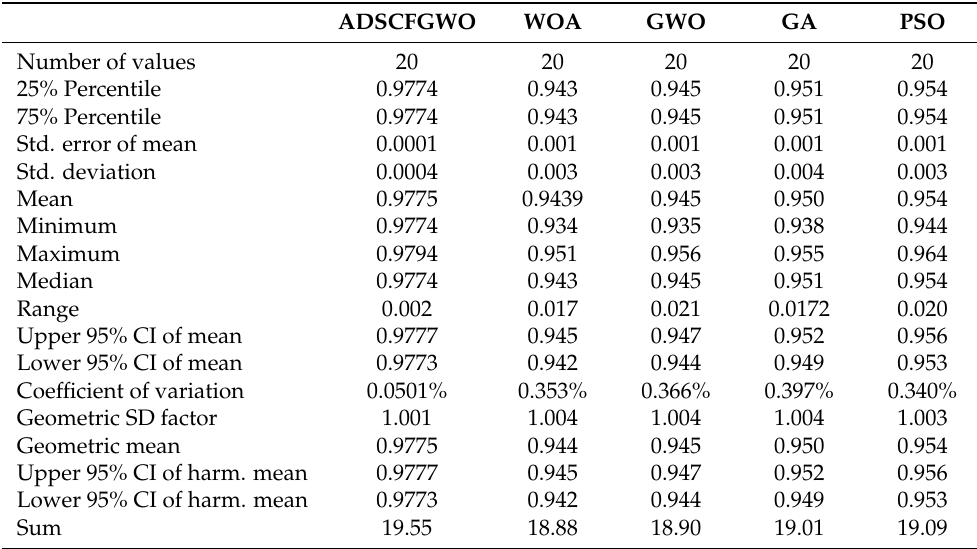
Table 10. Statistical analysis of the achieved classification results using the proposed optimized voting ensemble model.